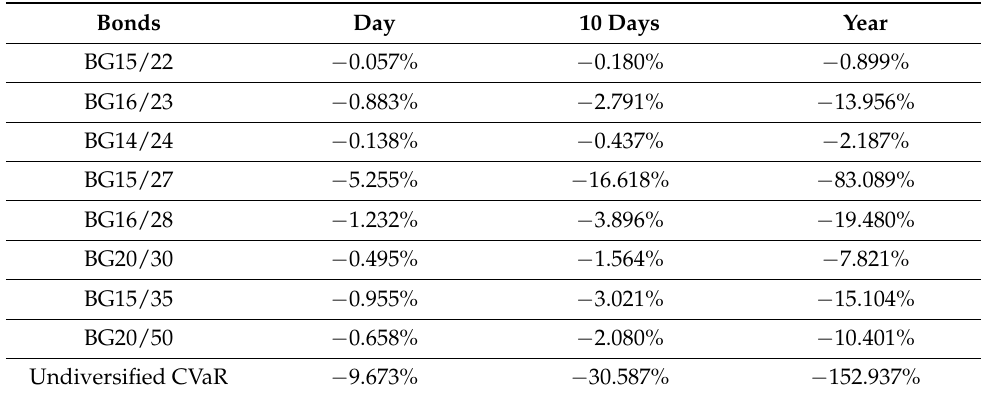
Table 6. YTM return correlation matrix of Bulgarian’s Sovereign Bonds.